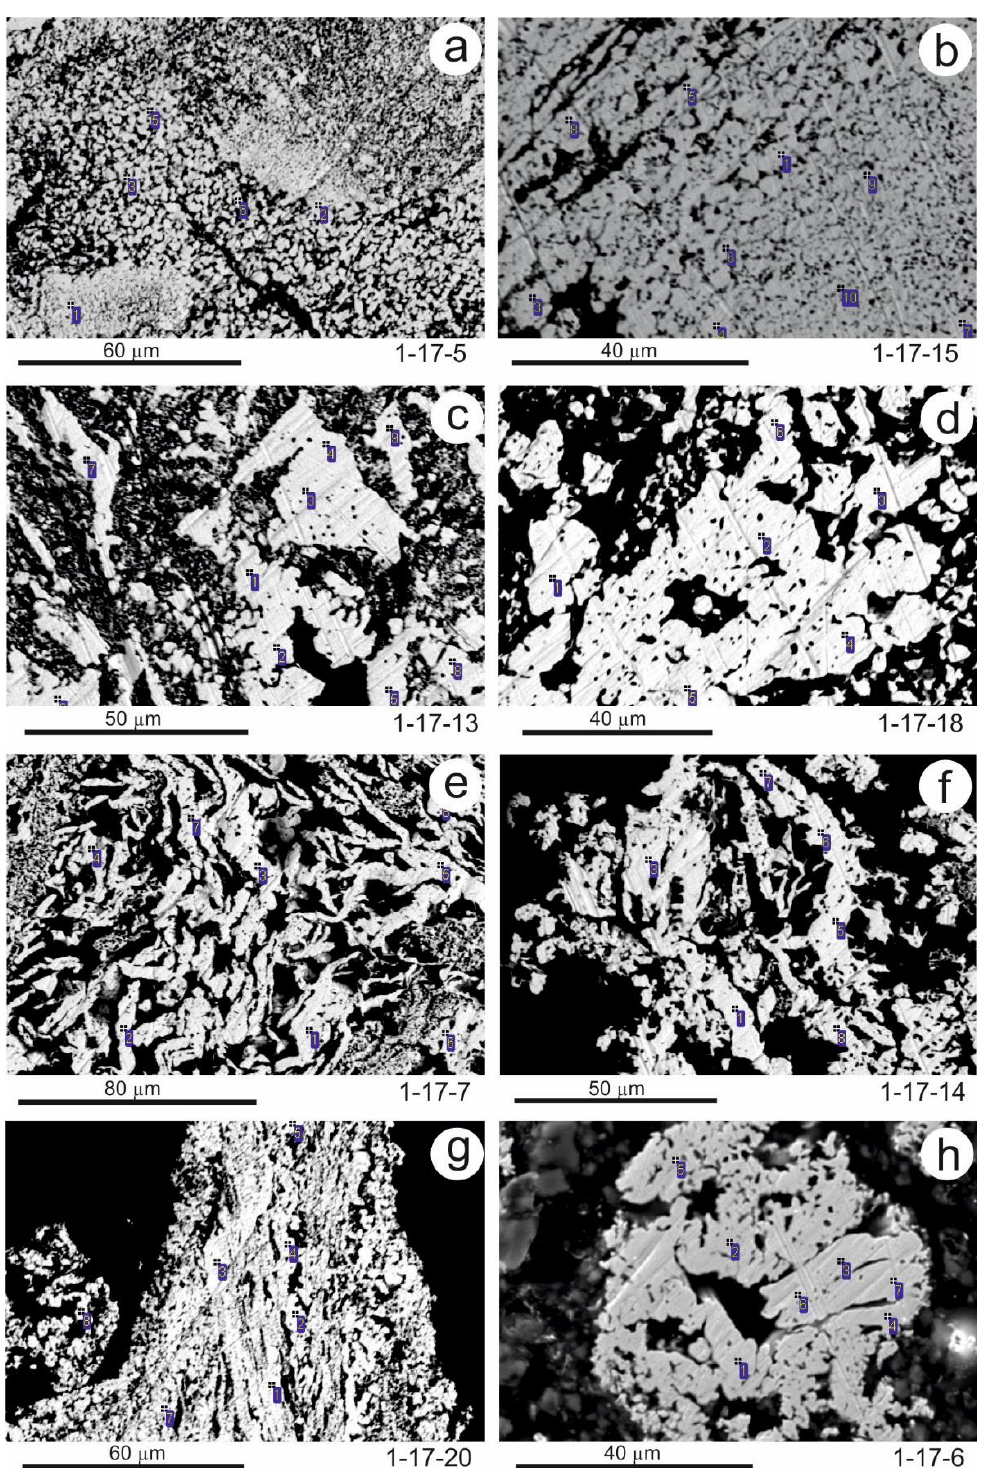
Figure 10. The internal structure of mustard-spongy ( a,b,h ) and dendritic mustard ( c – g ) gold. Fragments of the gold shown in Figures 6 – 8. ( a,b ) brain structure; ( c,d ) massive golds are cemented with microporous mustard gold; ( e,f ) tortuous gold in the cement of microporous mustard-sponge gold; ( g ) streaky-meandering golds in the center are bordered with brain-shaped golds; ( h ) a lump of gold of the brain-structure. Mounted sections, scanning electron microscope, back-scattering electron